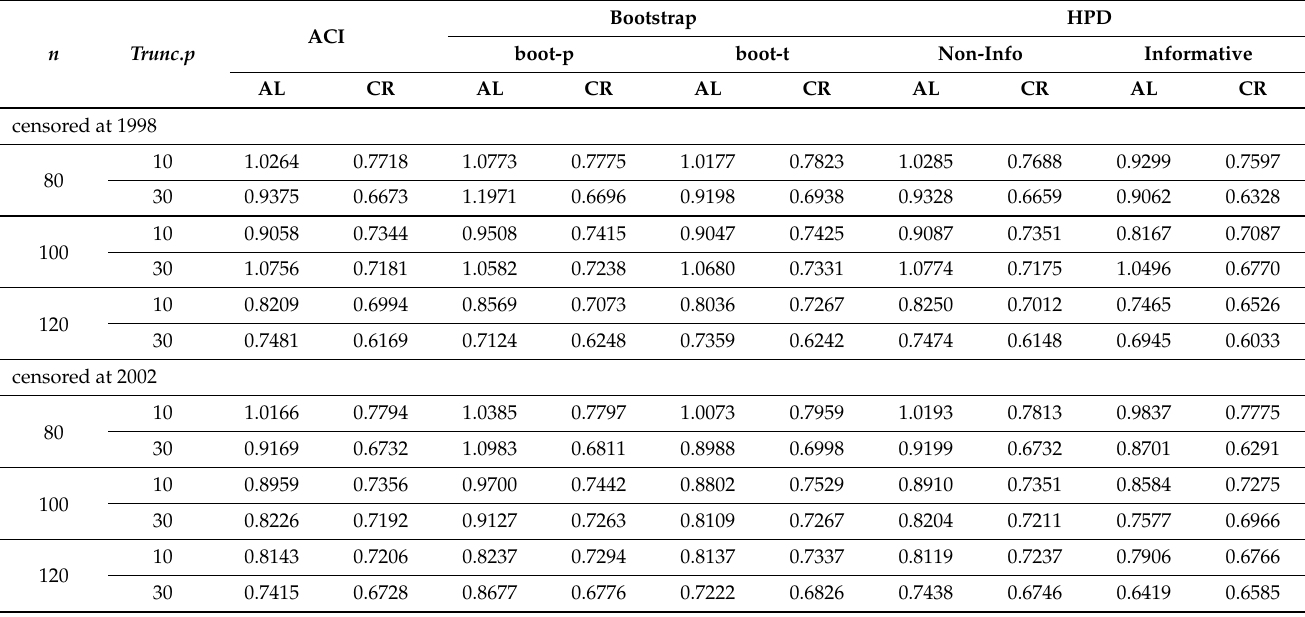
Table A6. The simulation results of five intervals for λ at 90% confidence/credible